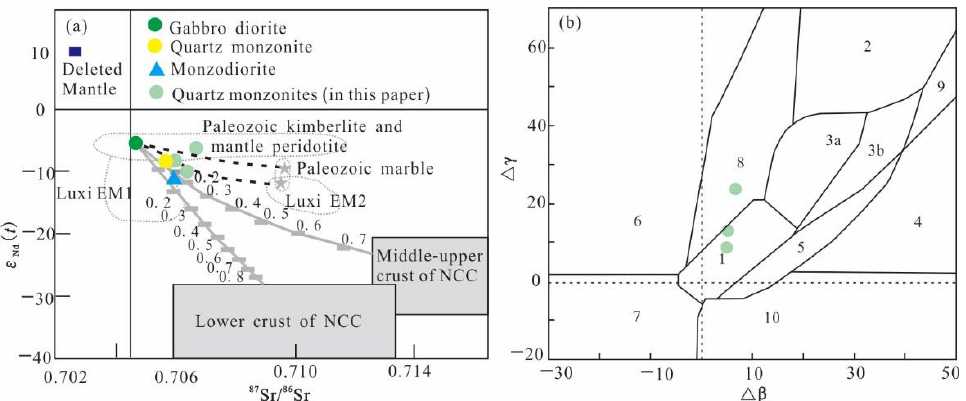
Figure 7. ( 87 Sr/ 86 Sr) i vs. ε Nd (t) diagram ( a ) and Δβ - Δγ diagram ( b ) of quartz monzonites from Jinling area, the western Shandong province. 1 — Mantle lead; 2 — supracrustal lead; 3 — subducted lead from the supracrustal-mantle mixed substances (3a — magmatism;3b — sedimentation); 4 — Chemical deposit lead; 5 — submarine hydrothermal lead; 6 — medium to deep metamorphic lead; 7 — deep metamorphic supracrustal lead; 8 — orogenic belt lead; 9 — ancient shale subcrustal lead; 10 — retrograde metamorphic lead.